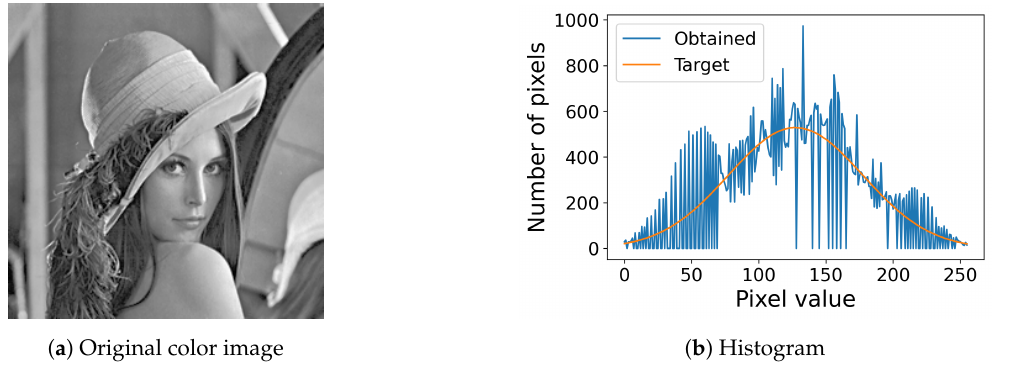
Figure 27. Histogram specification by Ramos’s algorithm [16]: ( a ) histogram specified image; ( b ) obtained and target